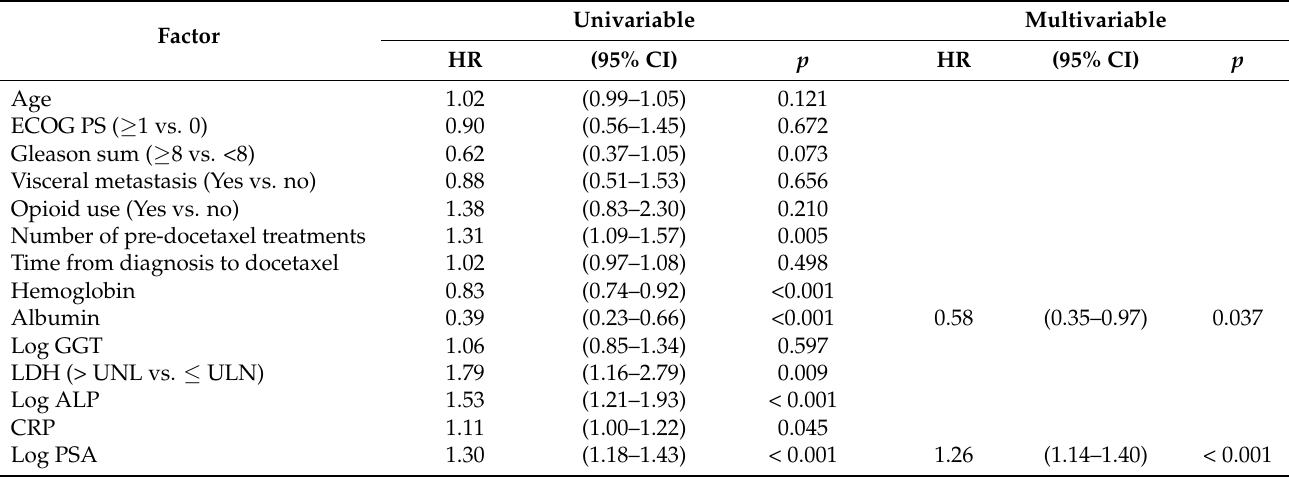
Table 4. Univariable and multivariable analyses for PSA and radiological PFS in 107 mCRPC men treated with